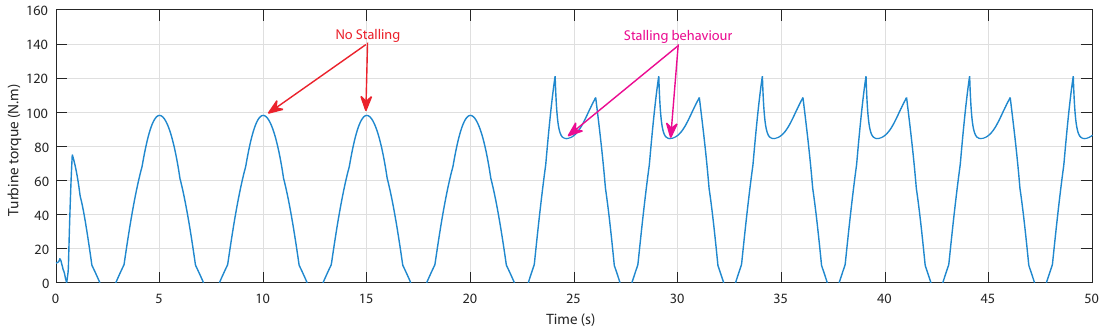
Figure 6. Turbine torques vs. time for two sea conditions